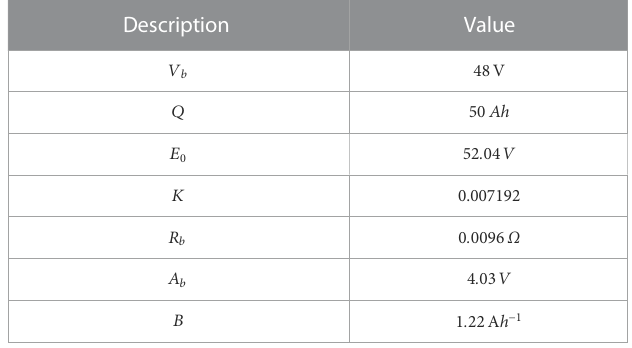
TABLE 2 The battery ’ s design